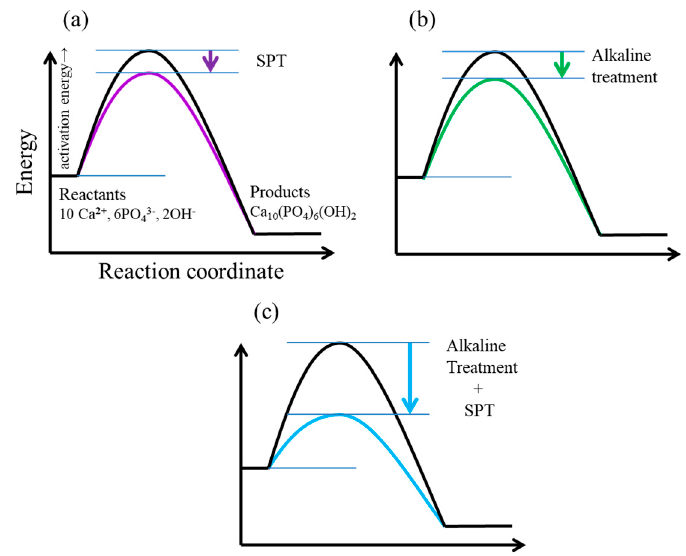
Figure 11. Energy profile in the hydroxyapatite formation. Activation energy of hydroxyapatite formation was lowered by ( a ) SPT and ( b ) alkaline treatment, and was notably lowered by ( c ) SPT and alkaline treatment and alkaline treatment and SPT.